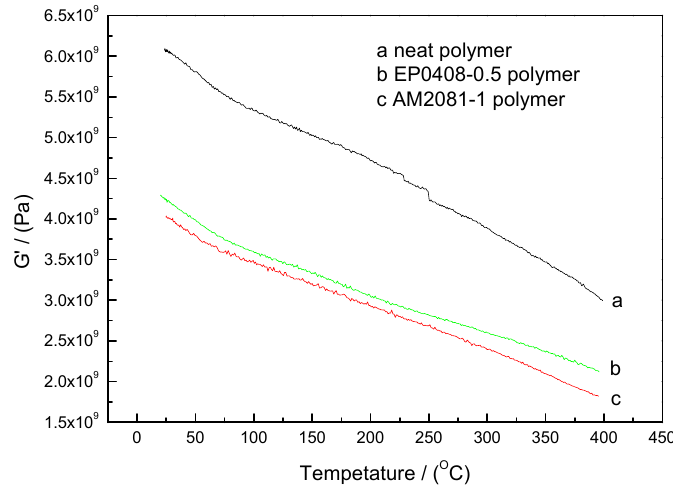
Figure 10. Dynamic storage modulus ( G ’) as a function of temperature for the neat polymer and the polymers containing AM0281 and EP0408 cured at 260 °C for 4 h, 300 °C for 8 h, and 325 °C for 8 h, and subsequently post-cured under an inert atmosphere of nitrogen at 350 °C for 8 h and 375 °C for 4 h. (a) Neat polymer, (b) EP0408-0.5 polymer, and (c) AM0281-1 polymer.